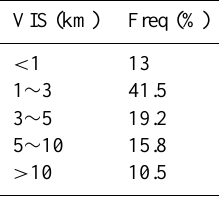
Table 1. Frequencies (Freq) of different visibility ranges.